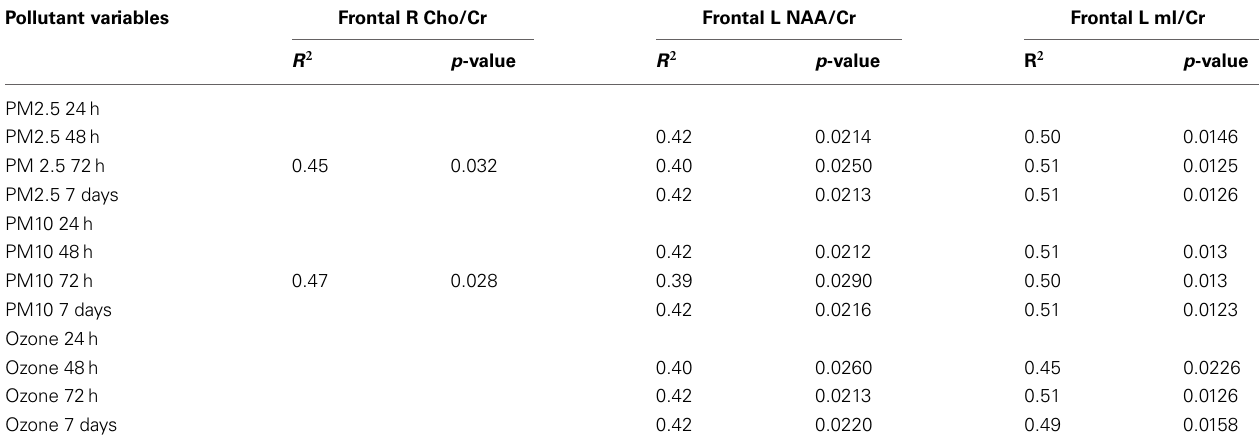
Table 6 | Statistically significant post-cocoa intervention differences in selected frontal MRS ratios associated with PM and ozone cumulative